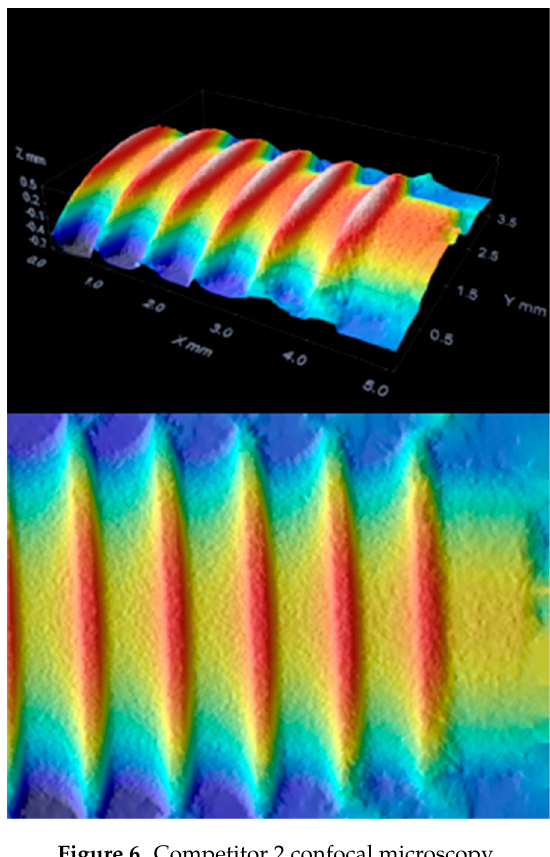
Figure 6. Competitor 2 confocal microscopy .